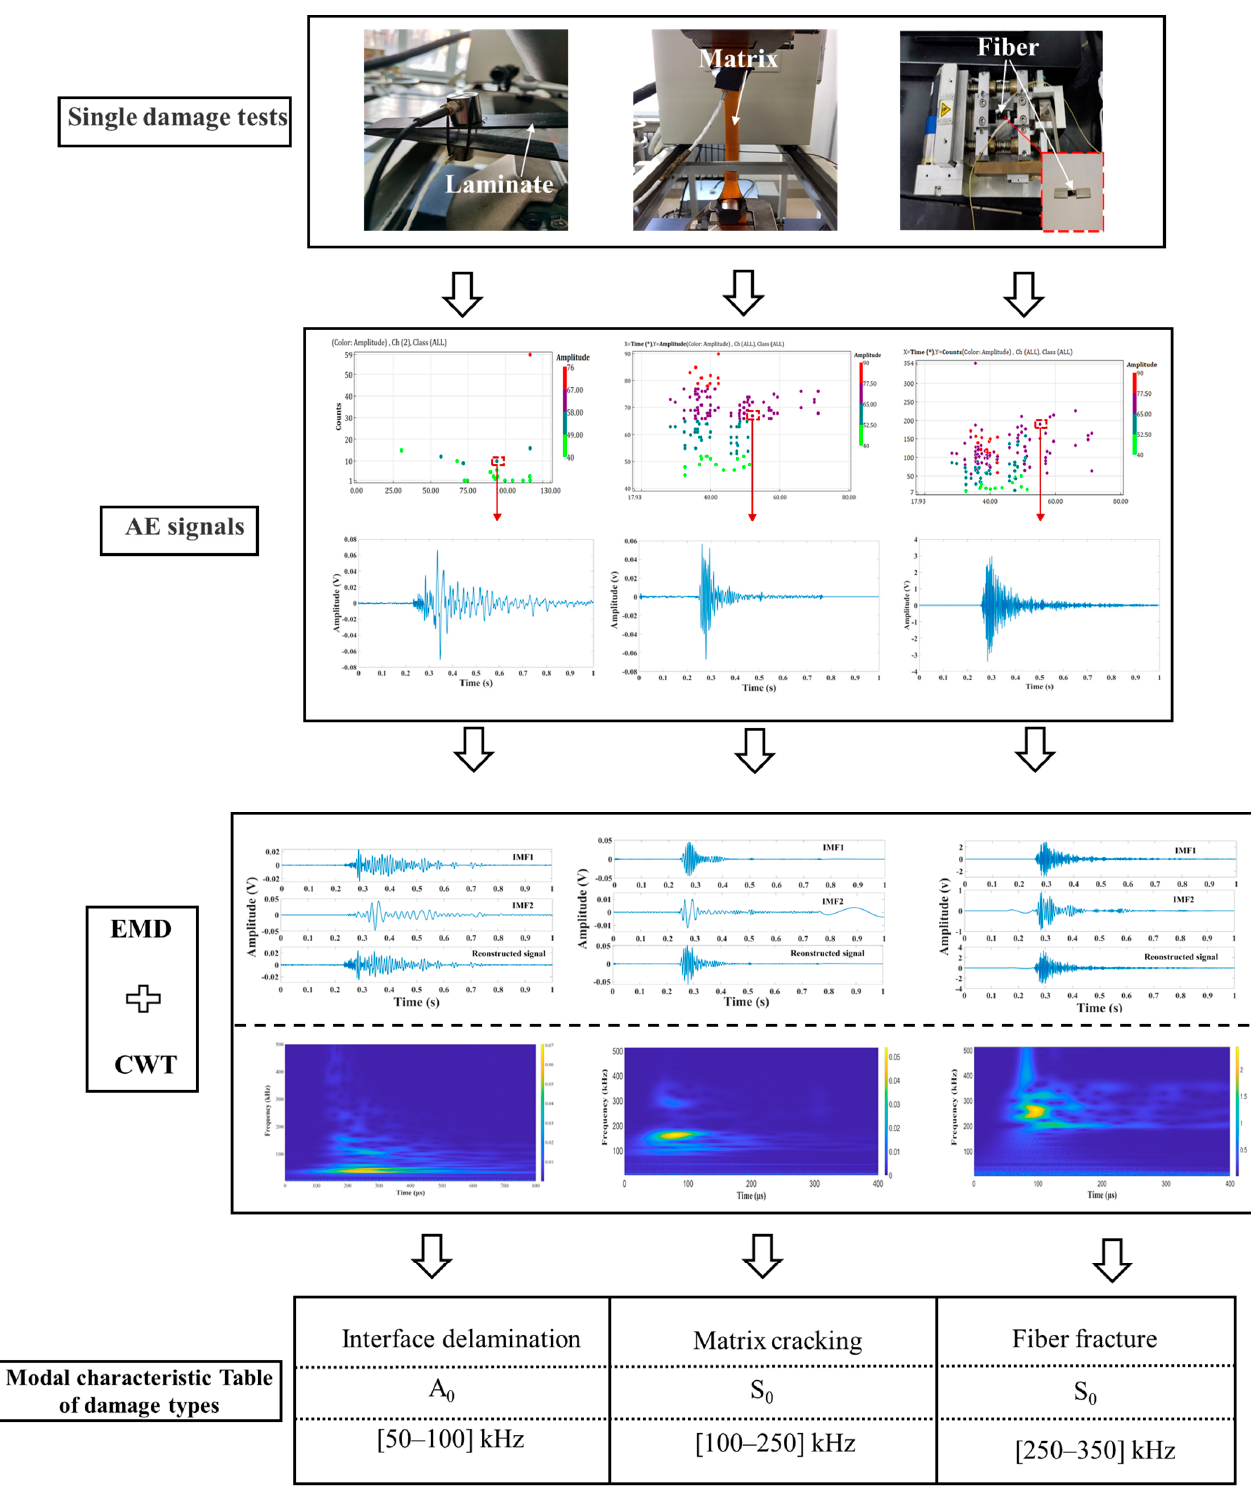
Figure 4. Damage modal feature extraction.